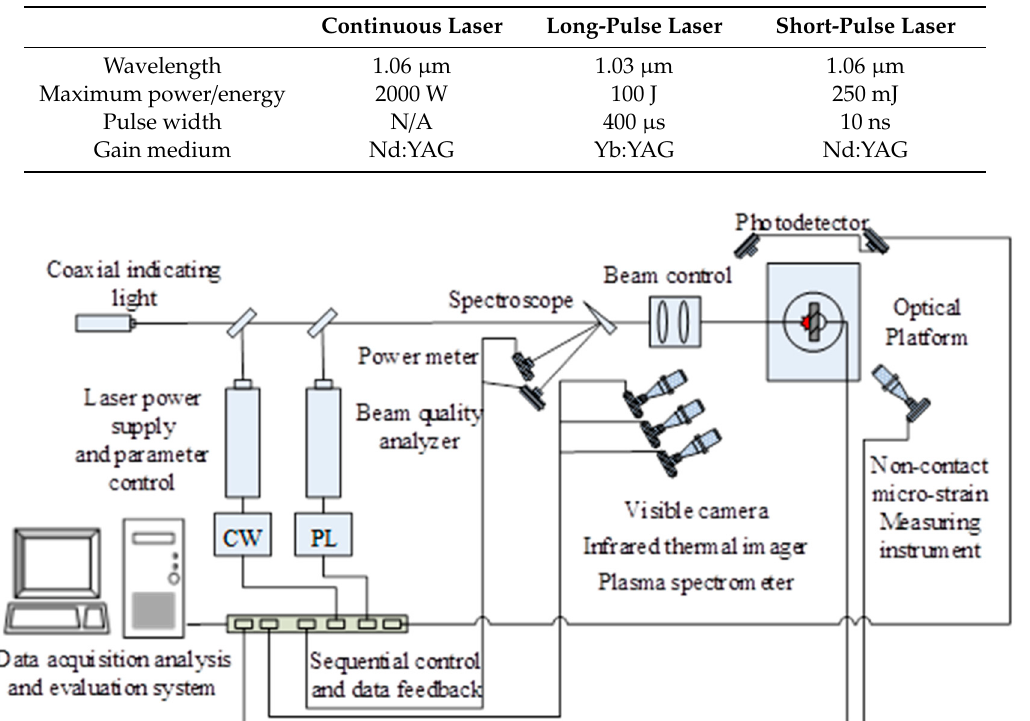
Table 1. Laser parameters.